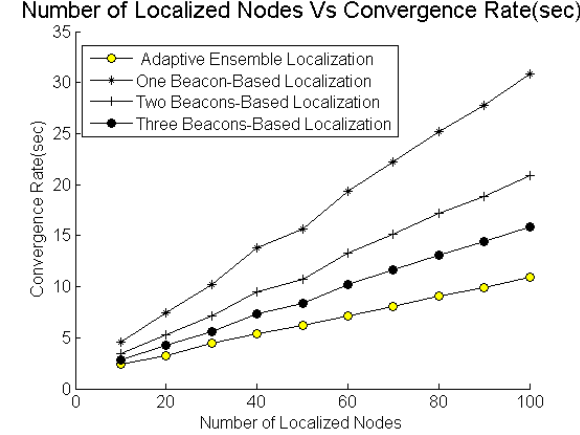
Figure 6. Number of localized nodes vs convergence rate